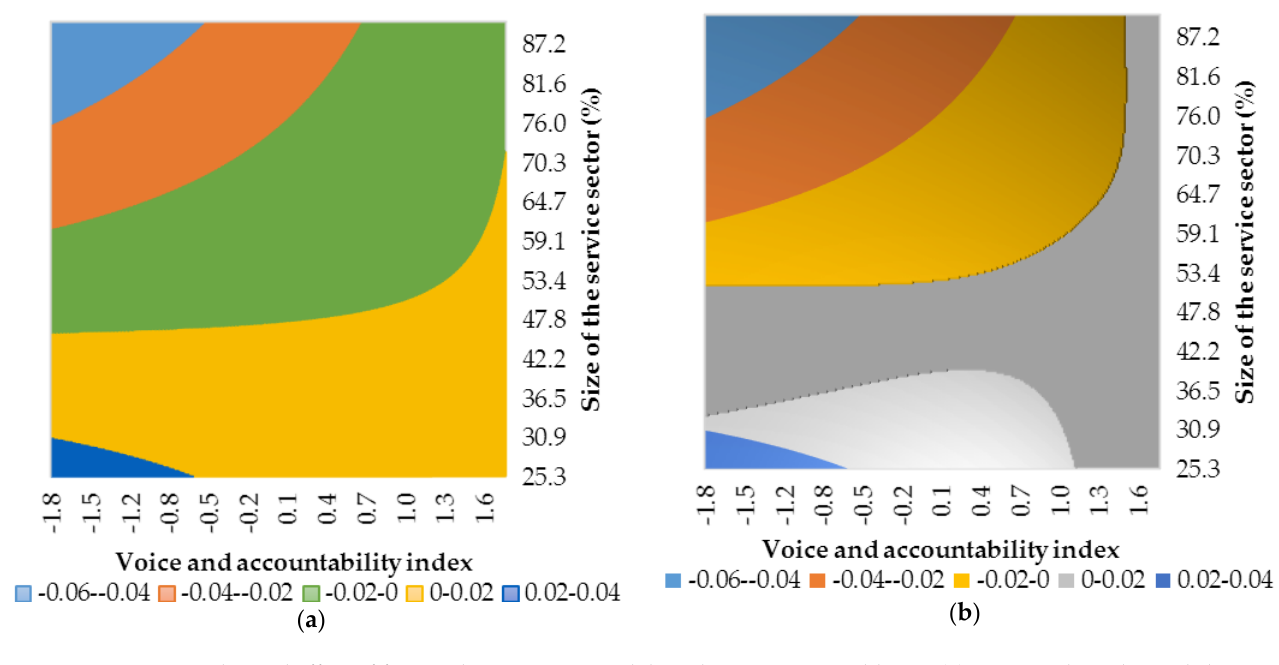
Figure A18. Conditional effect of financialisation on growth based on Est. 18 in Table A2. ( a ) Estimated conditional slope coefficient over the whole range of observed values for institutional quality and development level. ( b ) Estimated statistically significant conditional slope coefficient. Dark gray represents a combination of institutional quality and development level for which effect of financialisation on growth is statistically insignificant. Source: authors’ contributions.